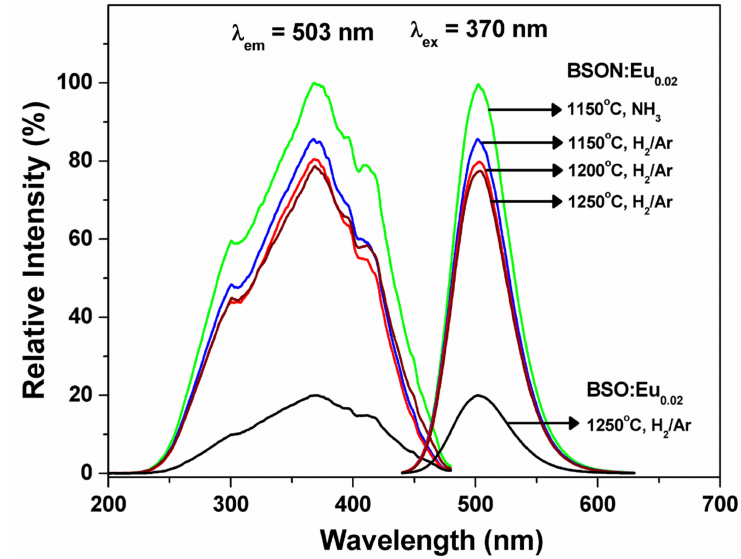
Figure 7. Photoluminescence (PL) spectra of BSO:Eu 2 + and BSON:Eu 2 + synthesized at di ff erent temperatures and atmospheres.